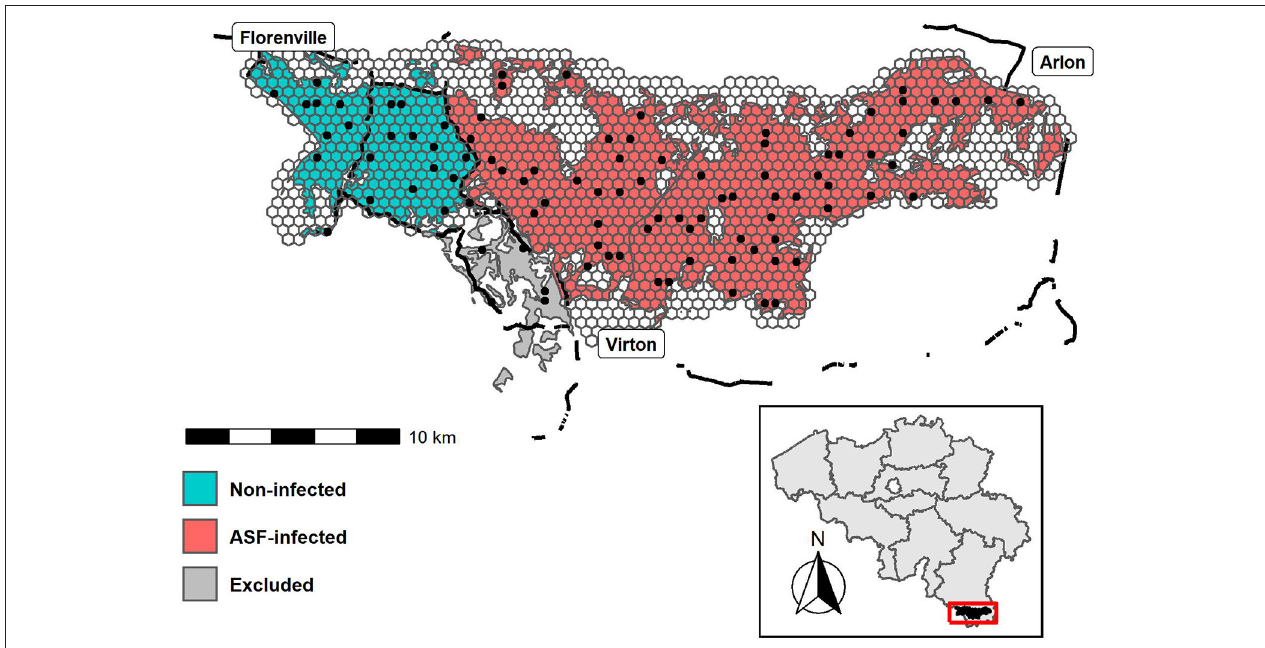
FIGURE 1 | Map of the study area with the overlaying hexagonal grids. Camera deployments are indicated by the black dots. Black lines represent fences. Colors represent the African swine fever management zones; ASF-infected (red), non-infected (turquoise) and excluded (gray). The inset map (bottom) shows the study area within